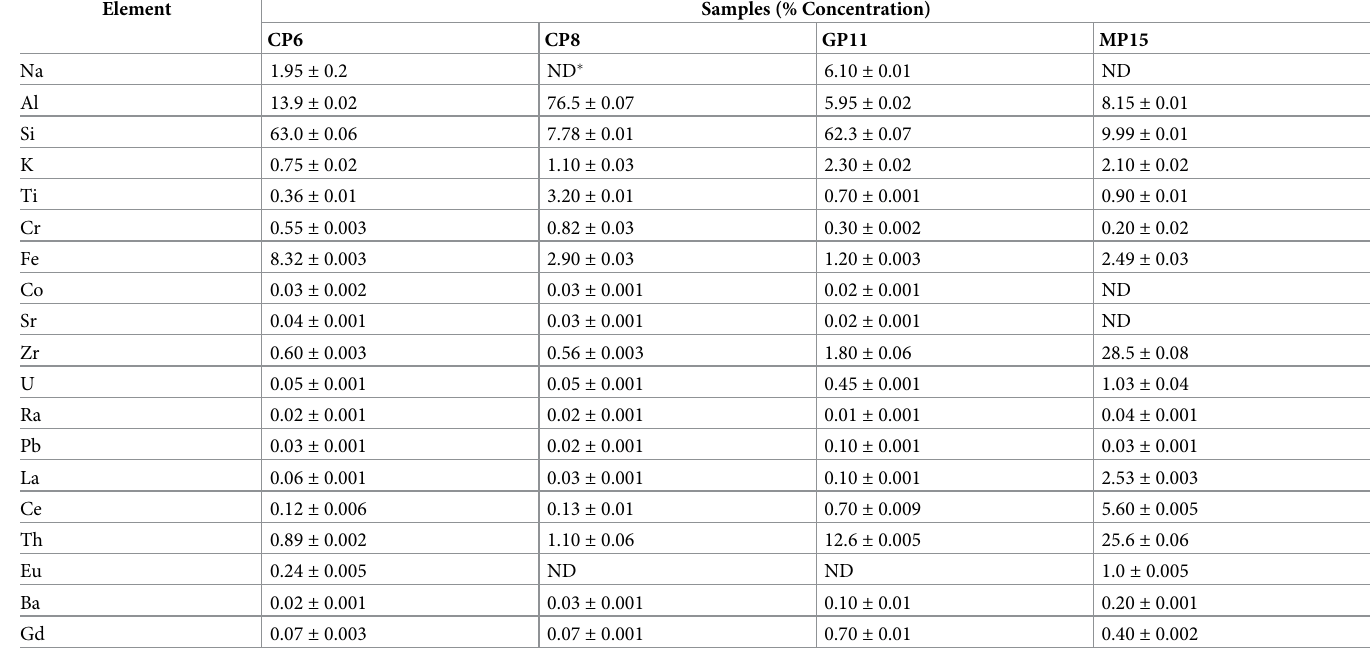
Table 2. Elemental composition of pendants.